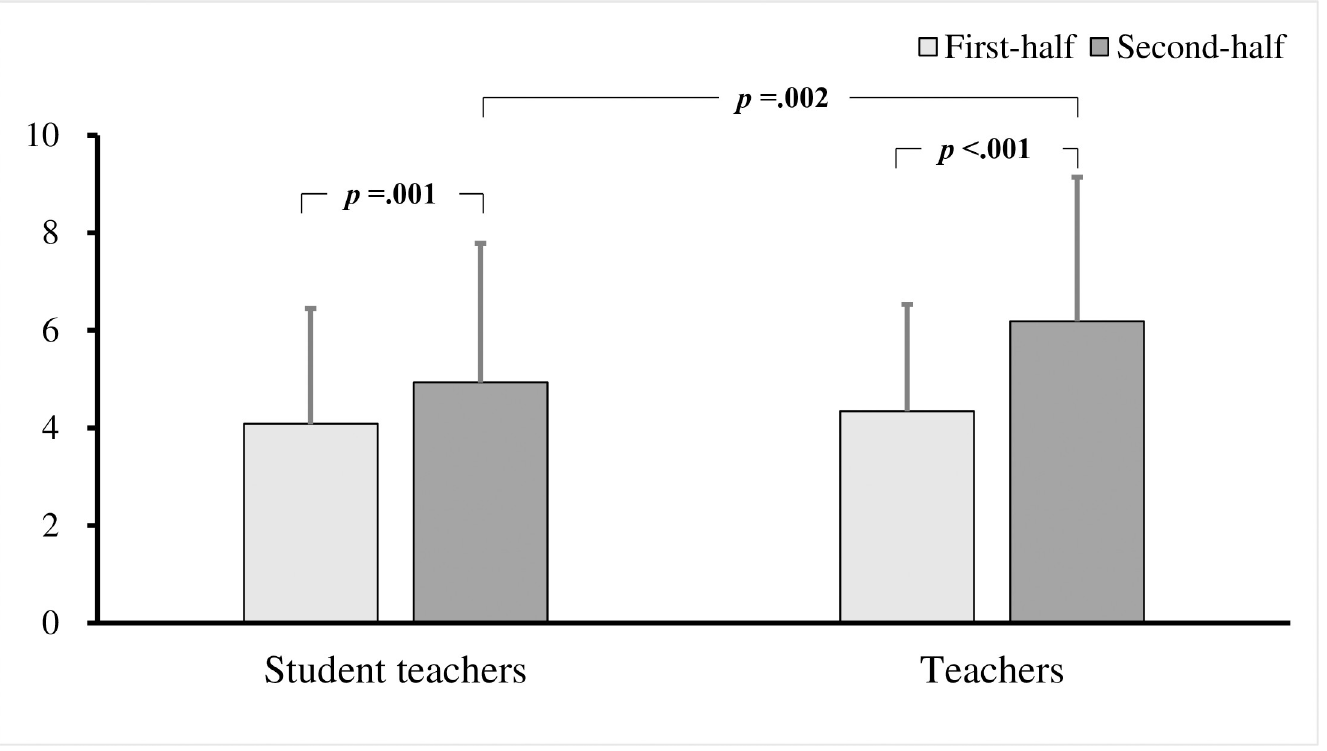
Fig 2. Number of fixations on target children in student teachers and teachers. Bars show the mean across all comparisons (with standard deviation bars).